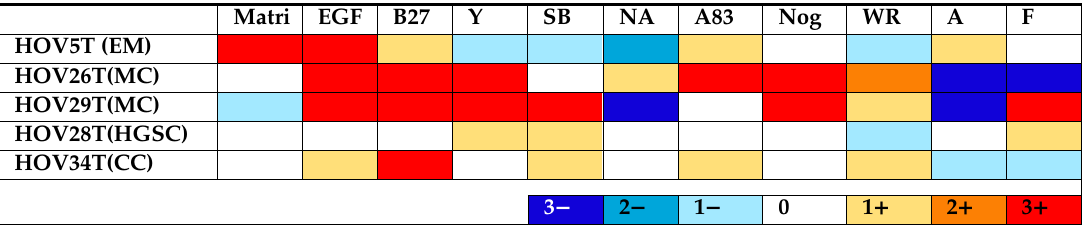
Table 2. E ff ect of individual components of medium B, di ff erent media or Matrigel-coating on proliferation of HOV lines. Matri EGF B27 Y SB NA A83 Nog WR